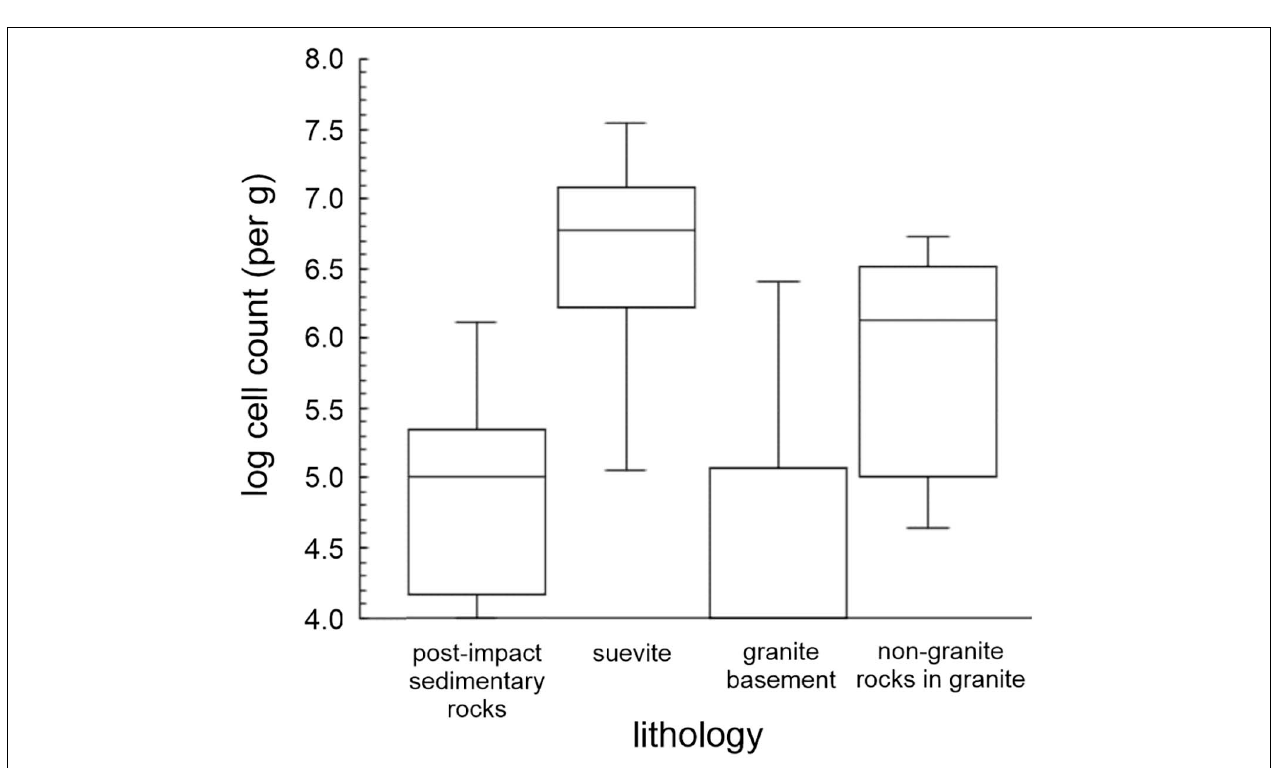
FIGURE 2 | Microbial abundance through the Chicxulub Expedition 364 (site 0077A) core. Diagram showing cell enumerations alongside total extracted DNA and total organic carbon (TOC) content, porosity, and open fractures. The limit of detection is taken as 1 × 10 4 cells/g. The horizontal lines separate the sections of suevite. TOC and porosity are displayed as moving averages of each 20 m depth. The classification of the geological units adopted by the drilling expedition scientists are shown alongside (see section “Materials and methods”).